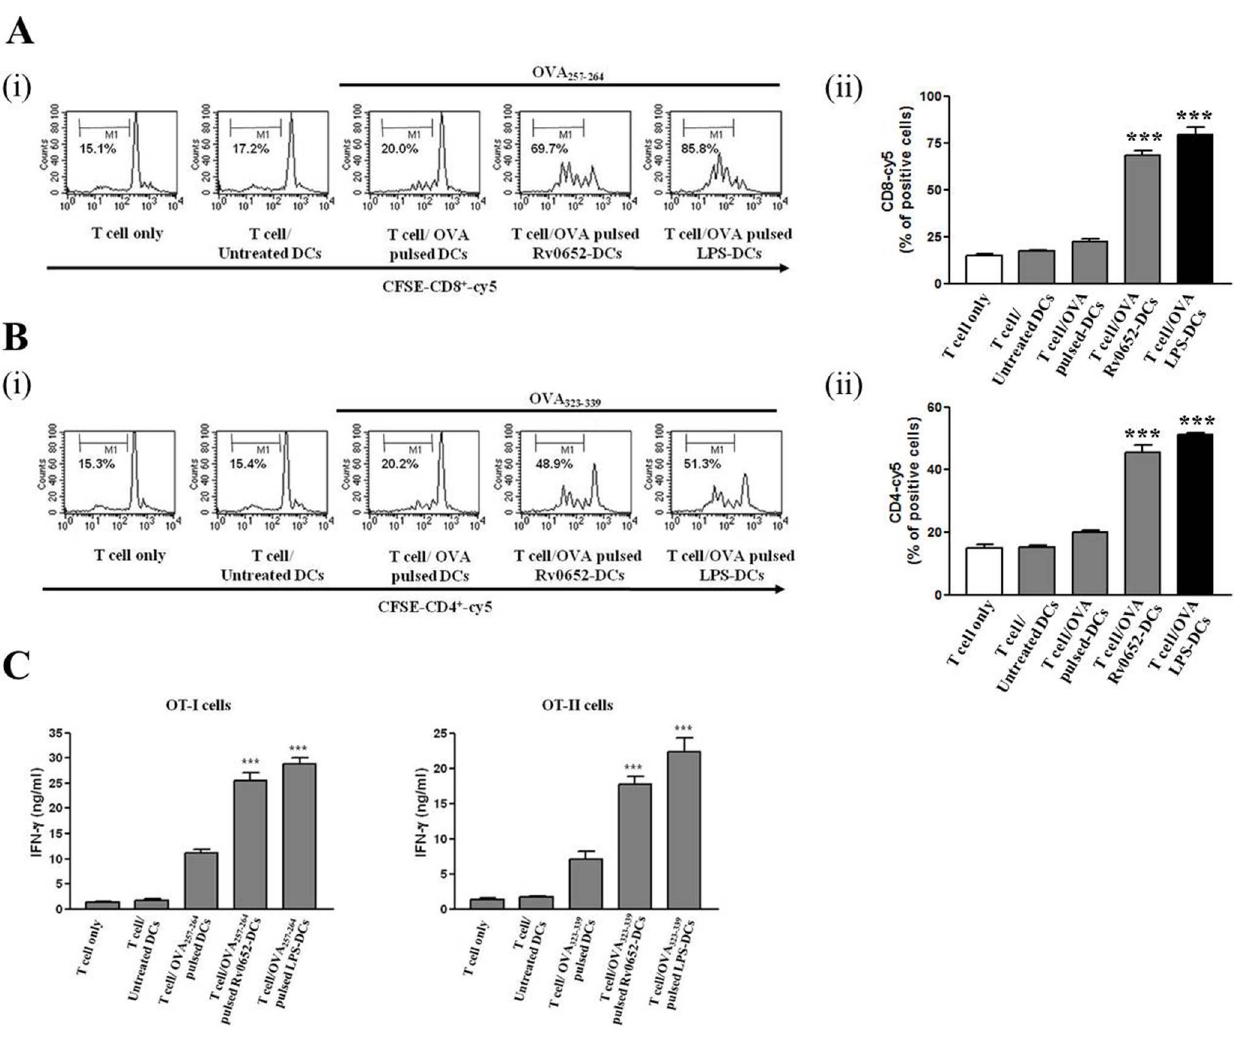
Figure 5. Rv0652-treated DCs induce proliferation of CD4 + and CD8 + T cells and a Th1 response. Transgenic OVA-specific CD8 + T cells (A- i) and OVA-specific CD4 + T cells (B-i) were isolated and stained using CFSE. These cells were then co-cultured for 96 h with untreated DCs, DCs pulsed with OVA 257–264 , Rv0652 (1 ug/ml)-treated DCs pulsed with OVA 257–264 , or LPS (200 ng/ml)-treated DCs pulsed with OVA 257–264 . T-cell proliferation was assessed using flow cytometry and the percentage of proliferating cells is shown in each panel. Bar graphs show the percentage of OVA-specific CD8 + T cells (A-ii) and OVA-specific CD4 + T cells (B-ii) from 3 independent experiments. *** P , 0.001 compared to T cells/OVA pulsed-DCs. (C) IFN- gamma production was measured in each culture supernatant from Fig. 5A and 5B after 24 h of culture by performing an ELISA. Data are the mean and SEM of 3 experiments. *** P , 0.001 compared to the value from T cell/OVA peptide-pulsed DCs.